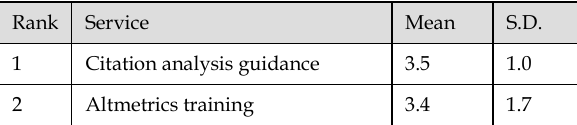
Table 6 Impact assessment stage services ranked